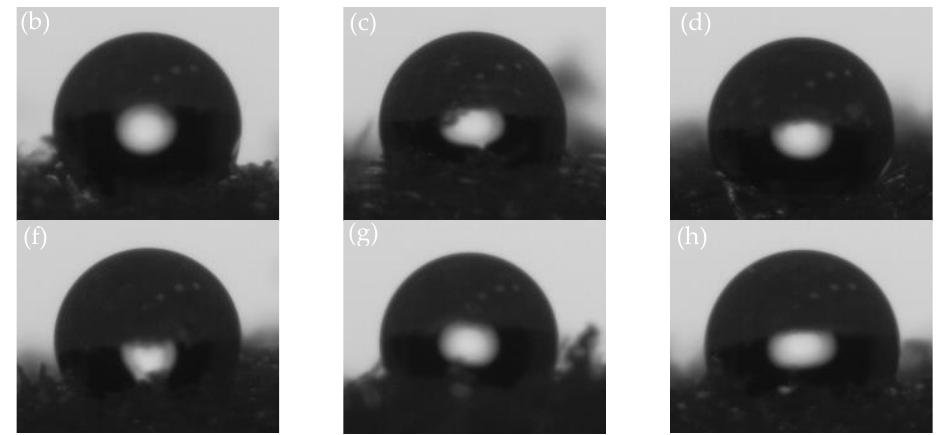
Figure 8. Water-related properties of rigid PU foams—water uptake and contact angle results.